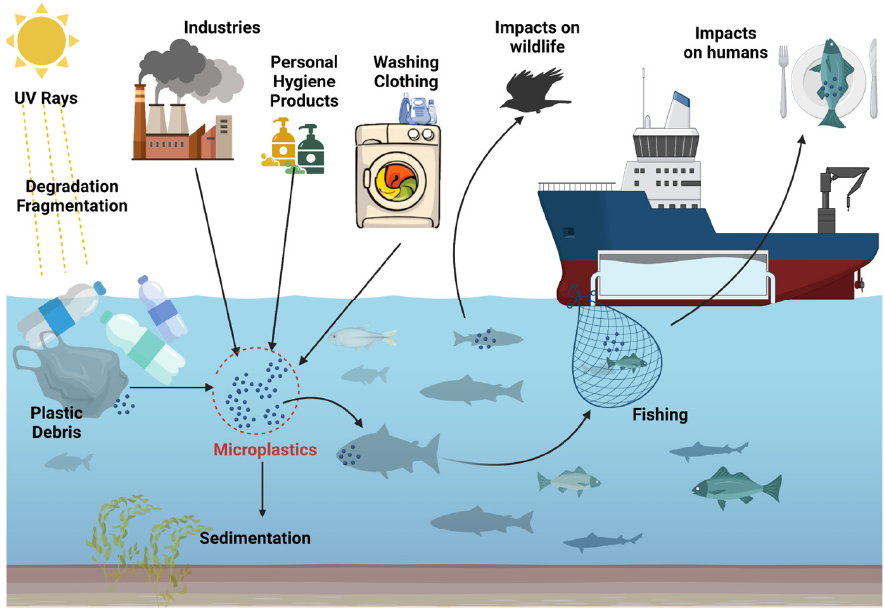
Figure 1. Microplastics in aquatic environment. Created with